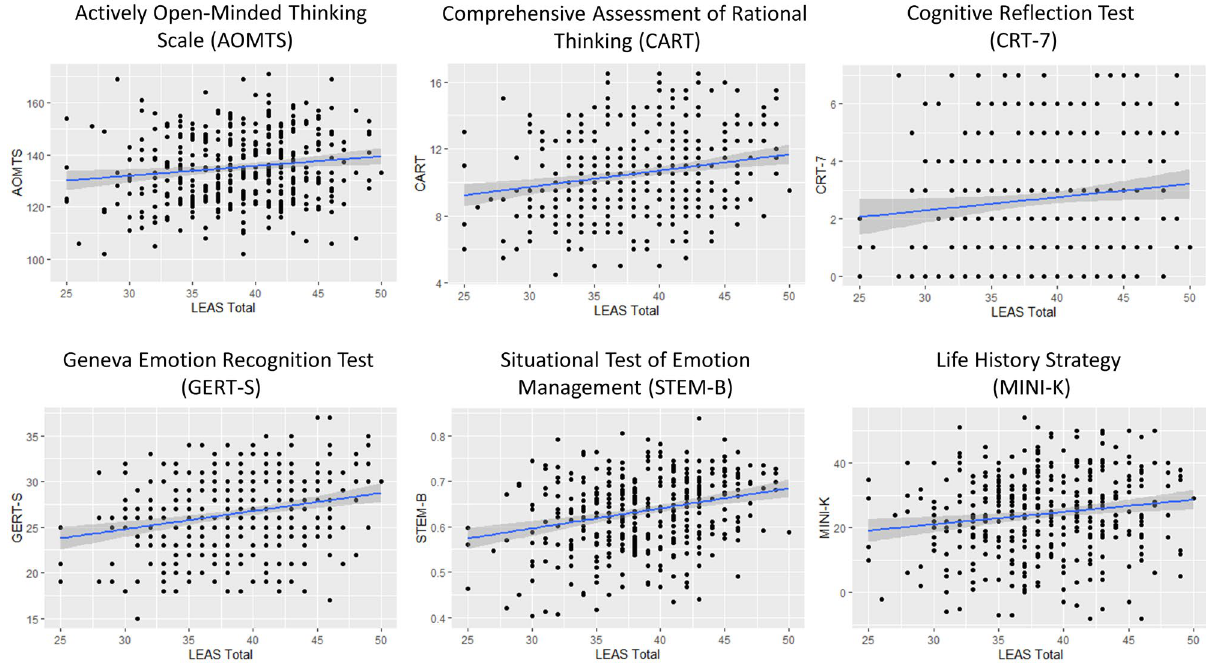
Figure 1. Scatterplots illustrating the relationship between LEAS total scores and three general reflective cognition measures (AOMTS, CART, CRT-7), as well as three socio-emotional cognition measures (GERT-S, STEM-B,